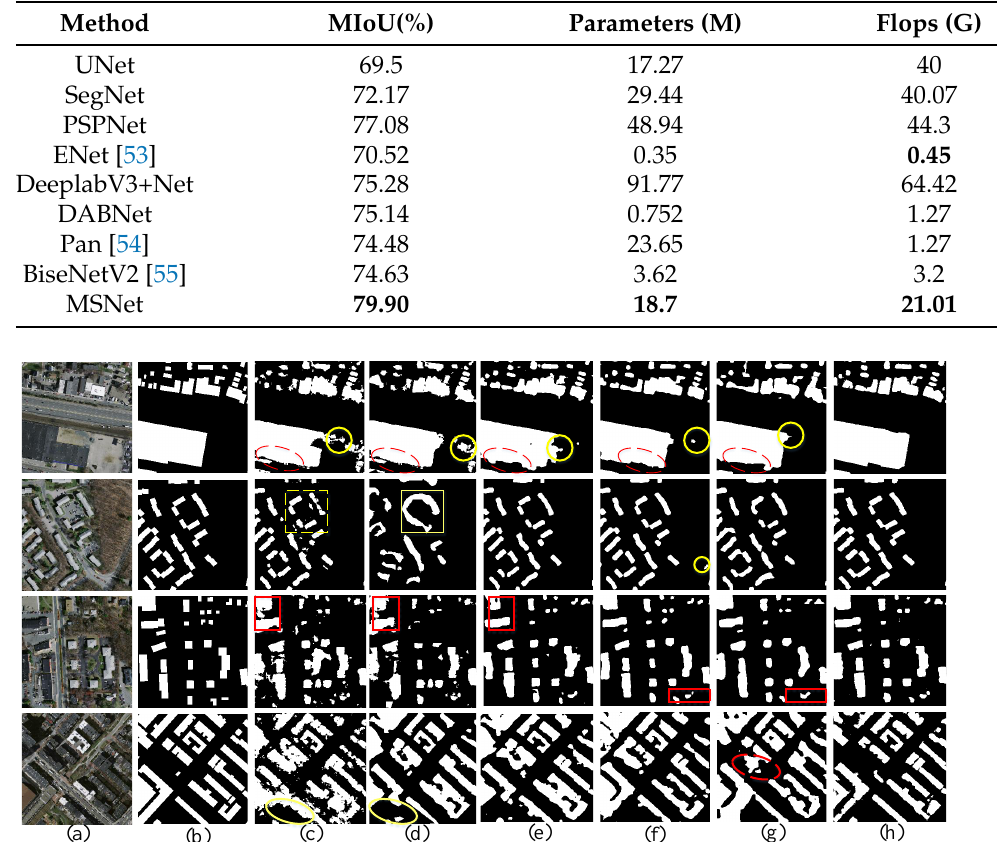
Figure 15. Diagram comparing the effects of the MIoU values of different models. ( a ) Real image; ( b ) label; ( c ) SegNet; ( d ) FCN32s; ( e ) DeepLabV3+; ( f ) PSPNet; ( g ) DABNet; ( h )